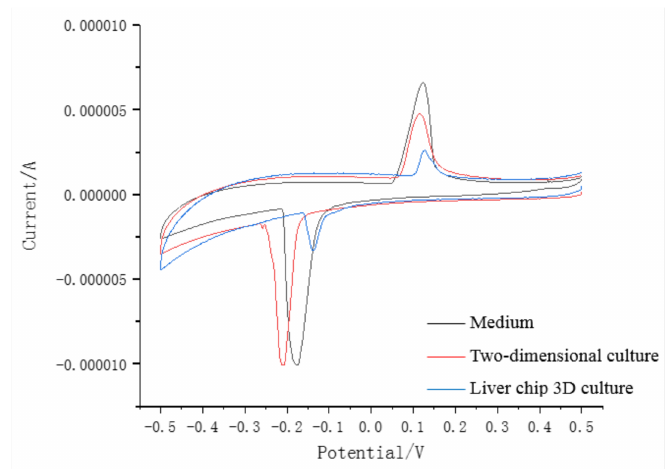
Figure 4. The electrochemical impedance of various liquid environment (day 1).